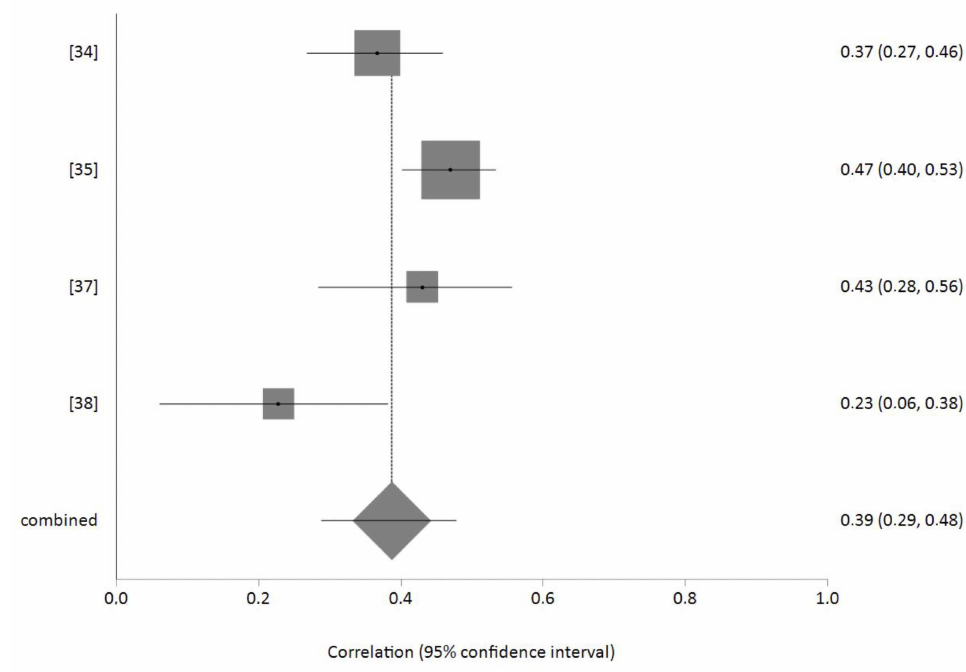
Figure 2. Forest plot of the relation between burnout and sleep